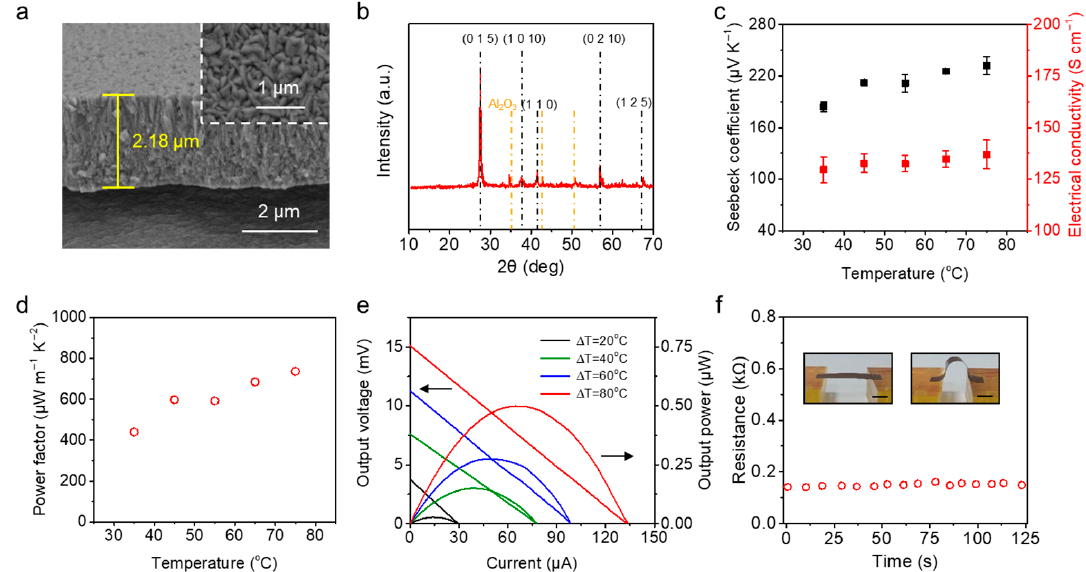
Figure 4. Characterizations of TE thin films. ( a ) SEM images of the cross-section view and surface morphology (inset) of the TE films. ( b ) XRD results of the TE film. The Bi 2 Te 3 film substrate is aluminum oxide ceramics. ( c , d ) Temperature-dependent of the Seebeck coefficient, the electrical conductivity and the corresponding power factor of TE films. ( e ) Output voltage and power of the TE film at different temperature differences. ( f ) Resistance of the TE film during repeated bending test. The inset illustrated the bending process, where the scale bar is 1 cm.